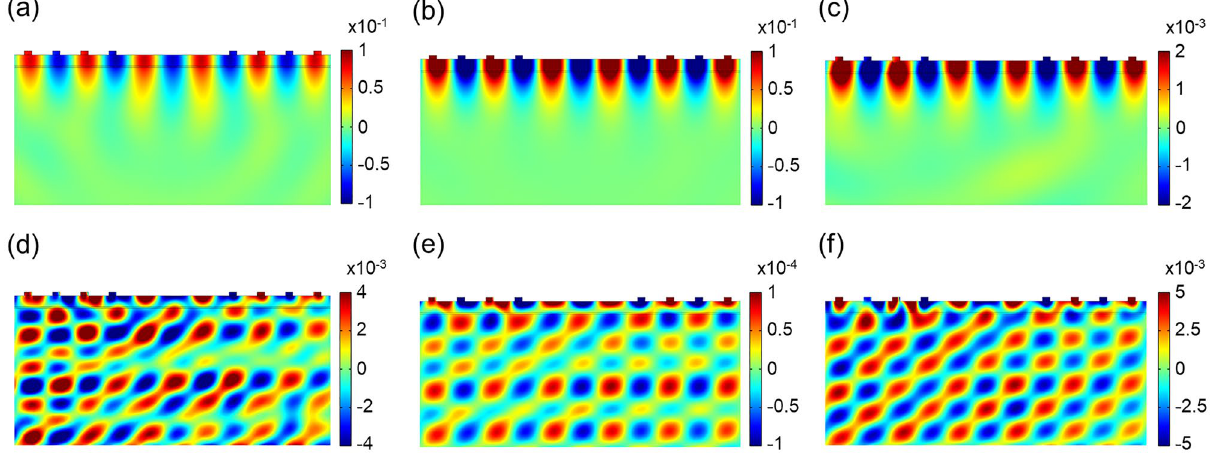
Figure 4. Distribution of displacement field (in nm) of piezoelectric material/h-BN/SiO 2 delay line model. ( a – c ) Rayleigh mode with energy concentrated on the surface for LiNbO 3 /h-BN/SiO 2 , LiTaO 3 /h-BN/SiO 2 , and ZnO/h-BN/SiO 2 , respectively. ( d – f ) Sezawa mode with energy penetrated down to the interface and substrate for LiNbO 3 /h-BN/SiO 2 , LiTaO 3 /h-BN/SiO 2 , and ZnO/h-BN/SiO 2 ,